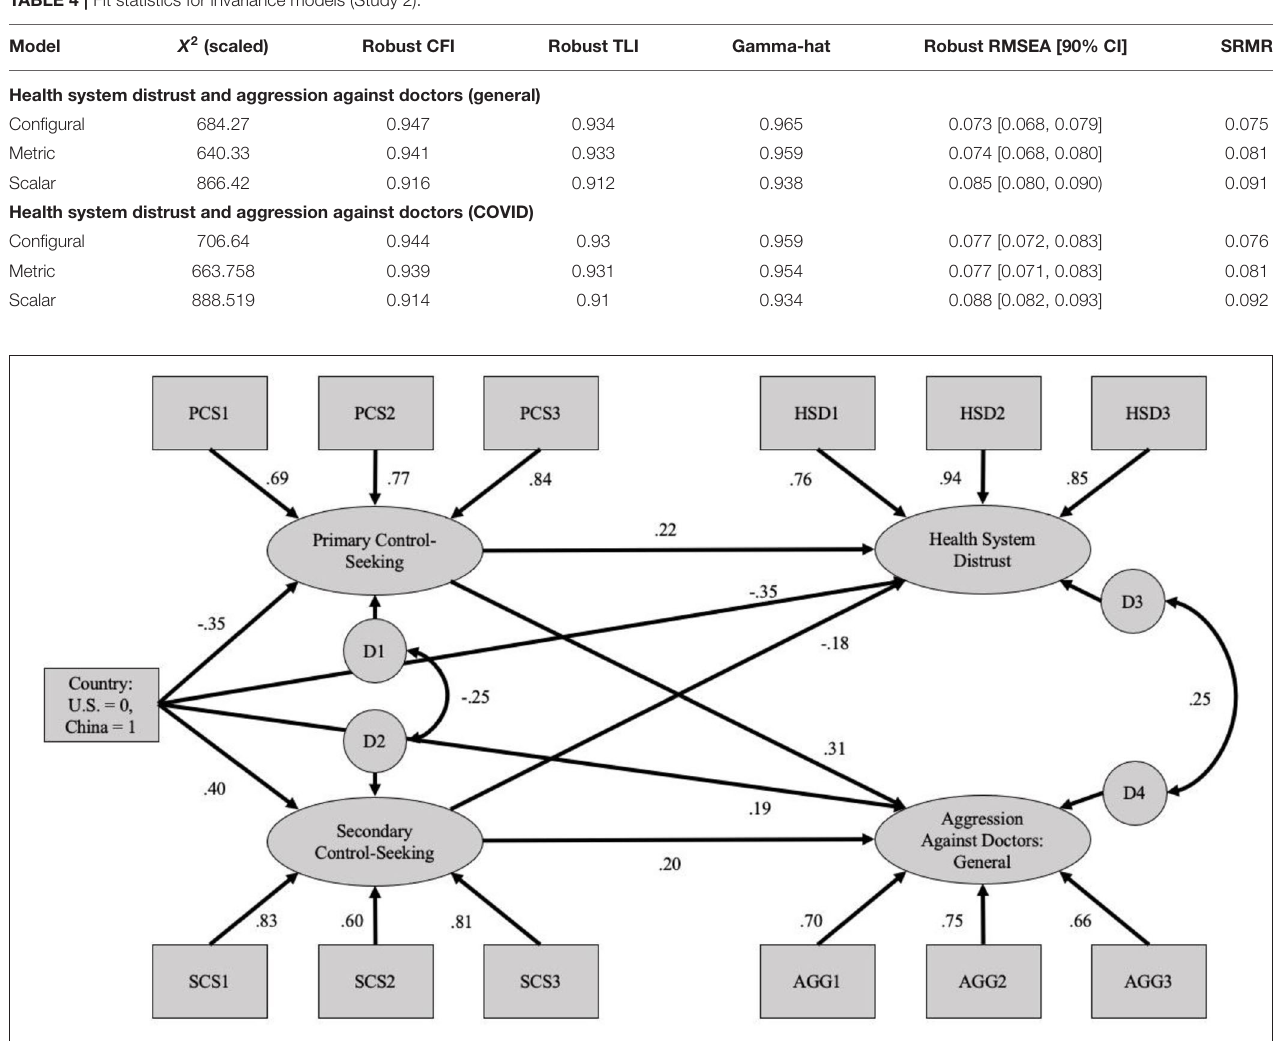
FIGURE 1 | Full structural equation model using the general aggression against doctors scenarios (Study